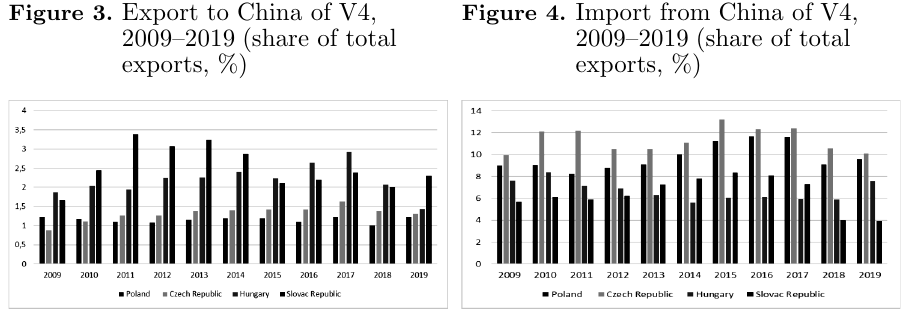
Figure 3. Export to China of V4, Figure 4. Import from China of V4,